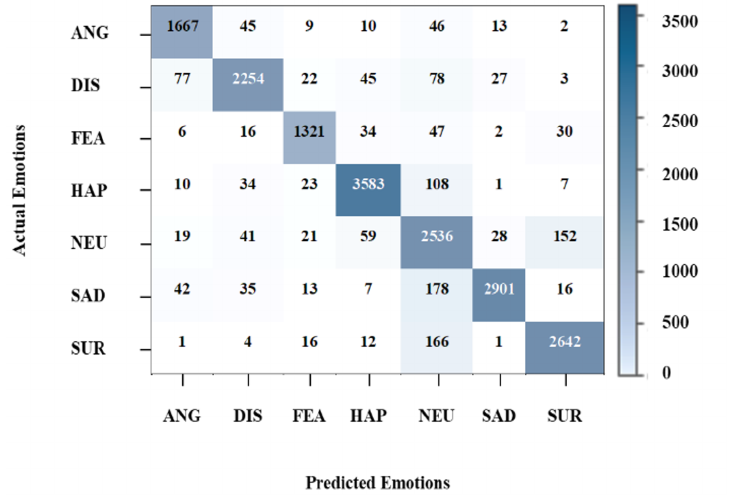
Figure 7. Confusion matrix of the proposed model after 100